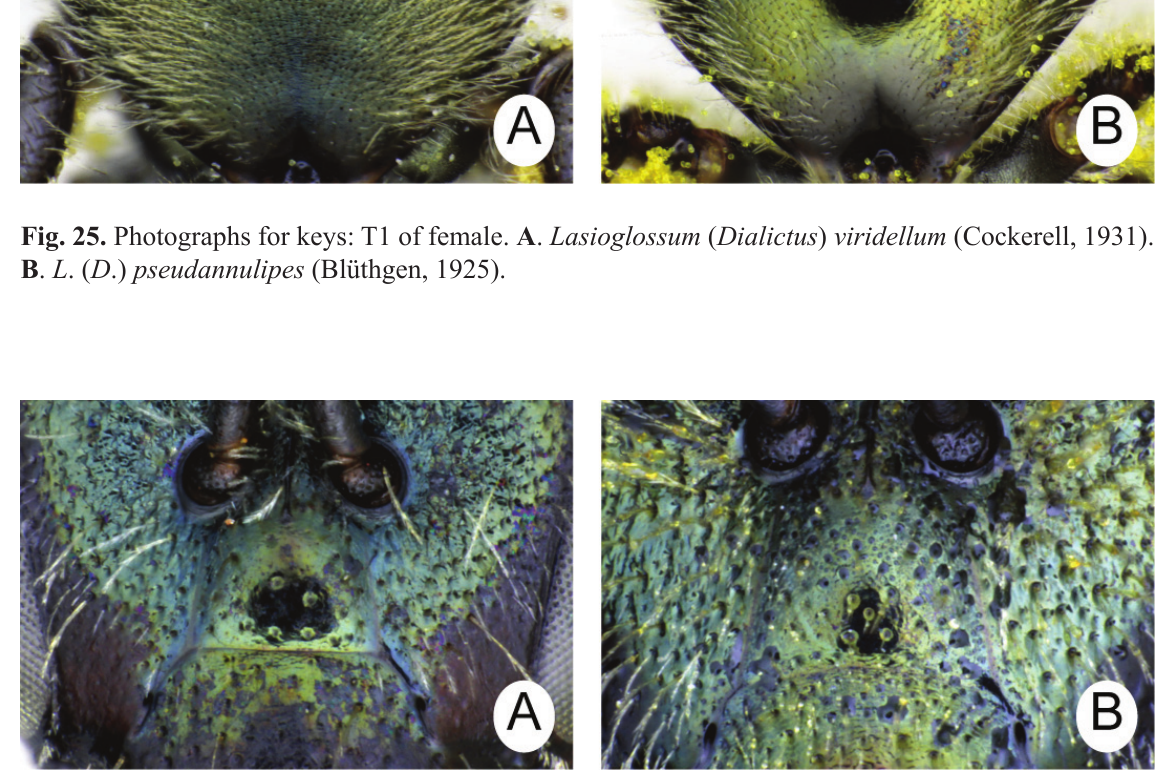
Fig. 26. Photographs for keys: PP on supraclypeal area of female. A . Lasioglossum ( Dialictus ) meakanense Murao & Tadauchi, 2009. B . L . ( D .) ellipticeps (Blüthgen,